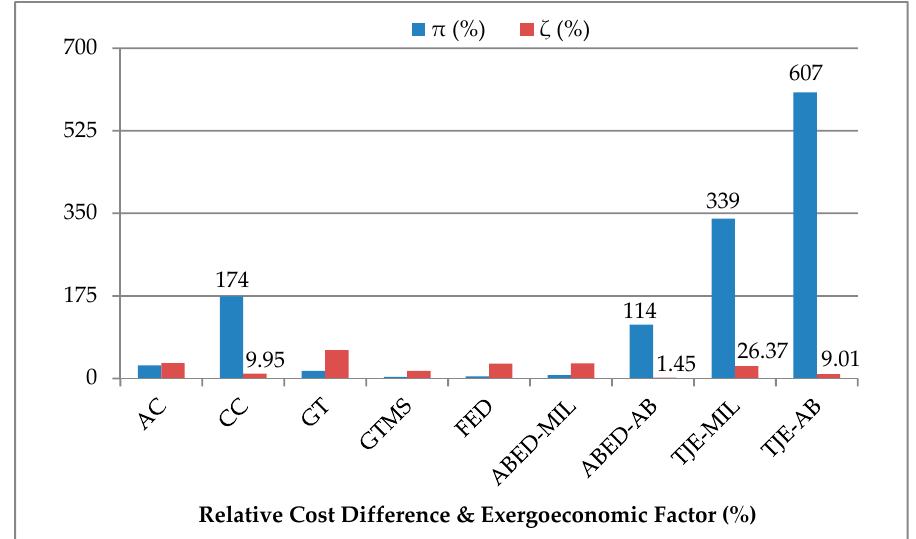
Figure 8. Relative cost difference ( π ) and exergoeconomic factor ( ζ) with H 2 fuel usage.